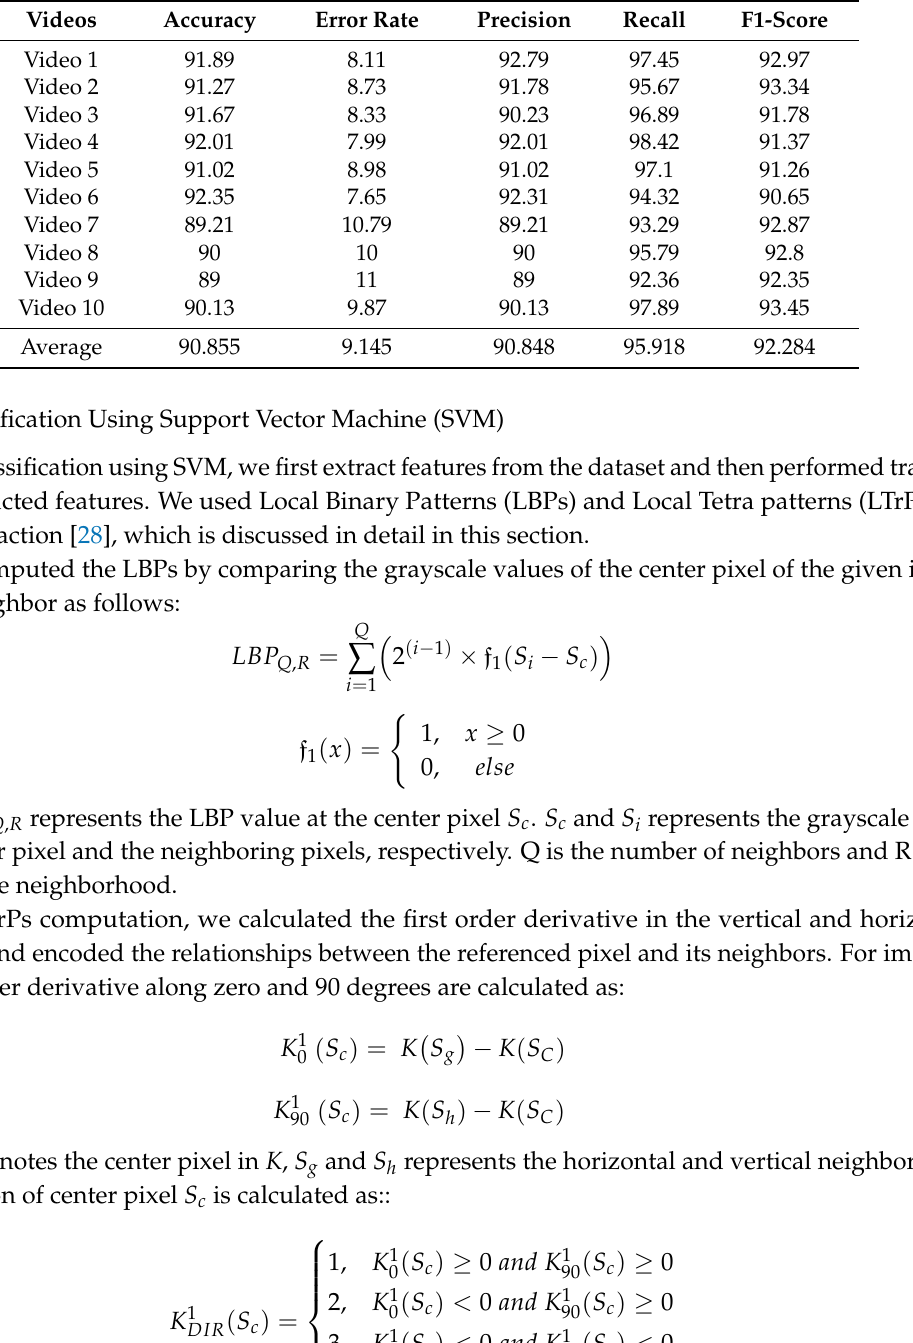
Table 2. Performance evaluation using